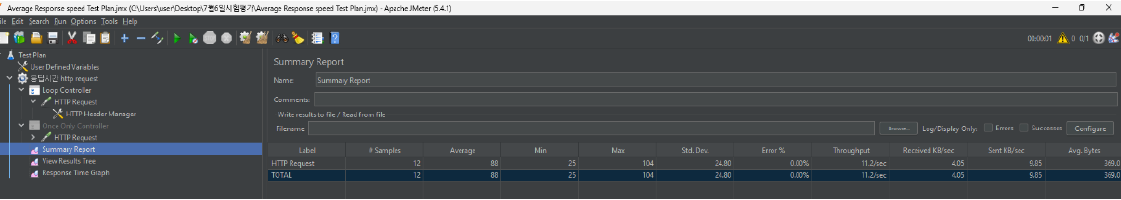
Figure 14. Screenshot of response time evaluation using Apache JMeter.